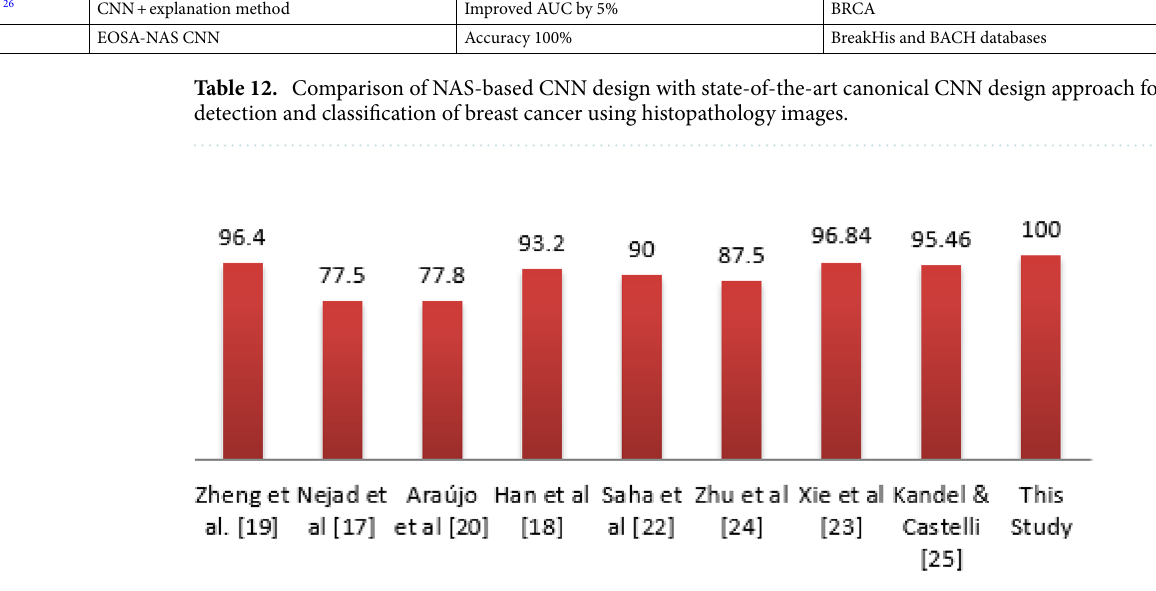
Figure 13. Comparison of the CNN architecture designed using EOSA-NAS model with state-of-the-art CNN architectures applied to the detection of breast cancer in histopathology